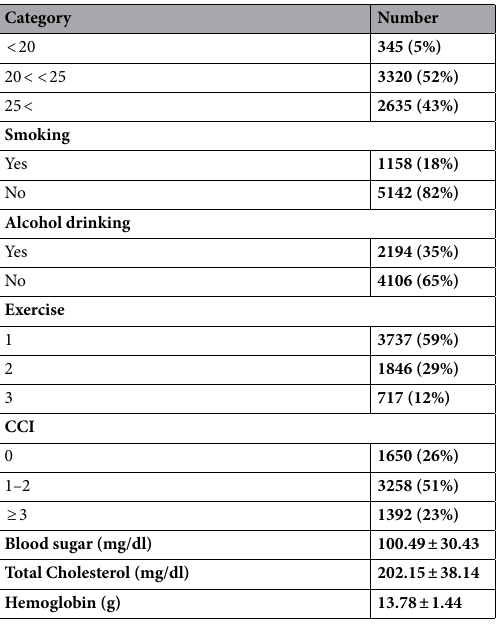
Table 1. Patient demographics. PELD, Percutaneous endoscopic lumbar discectomy; BMI, Body mass index; CCI, Charlson comorbidity